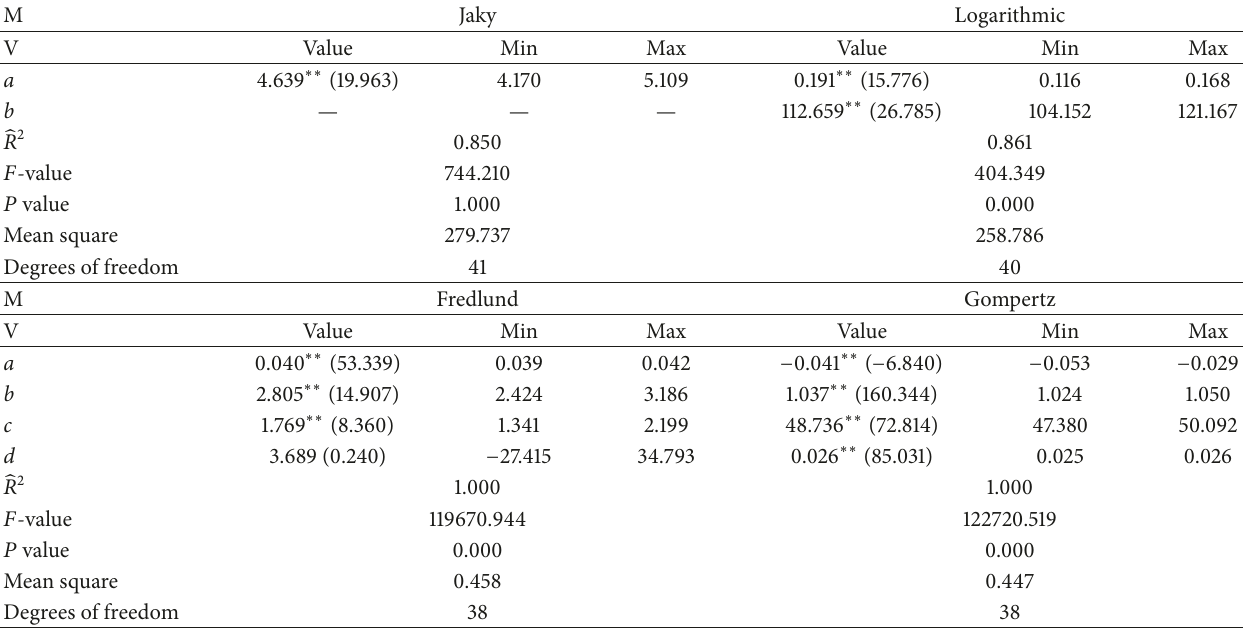
Table 3: Fitting parameters of H-5 by laser diffraction